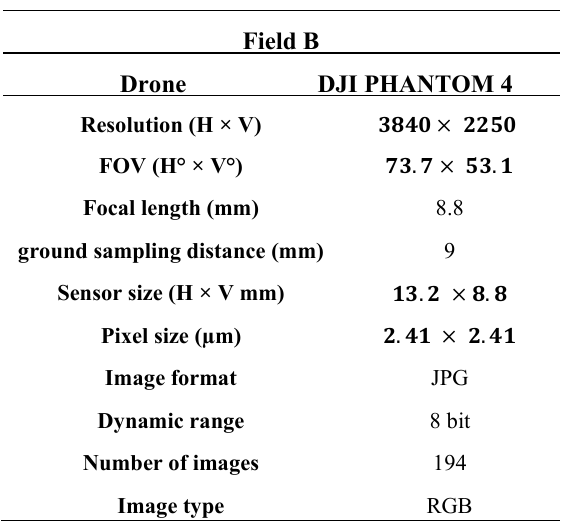
Table 2 . Unmanned aerial vehicle (UAV) sensor and image parameters of the field B database